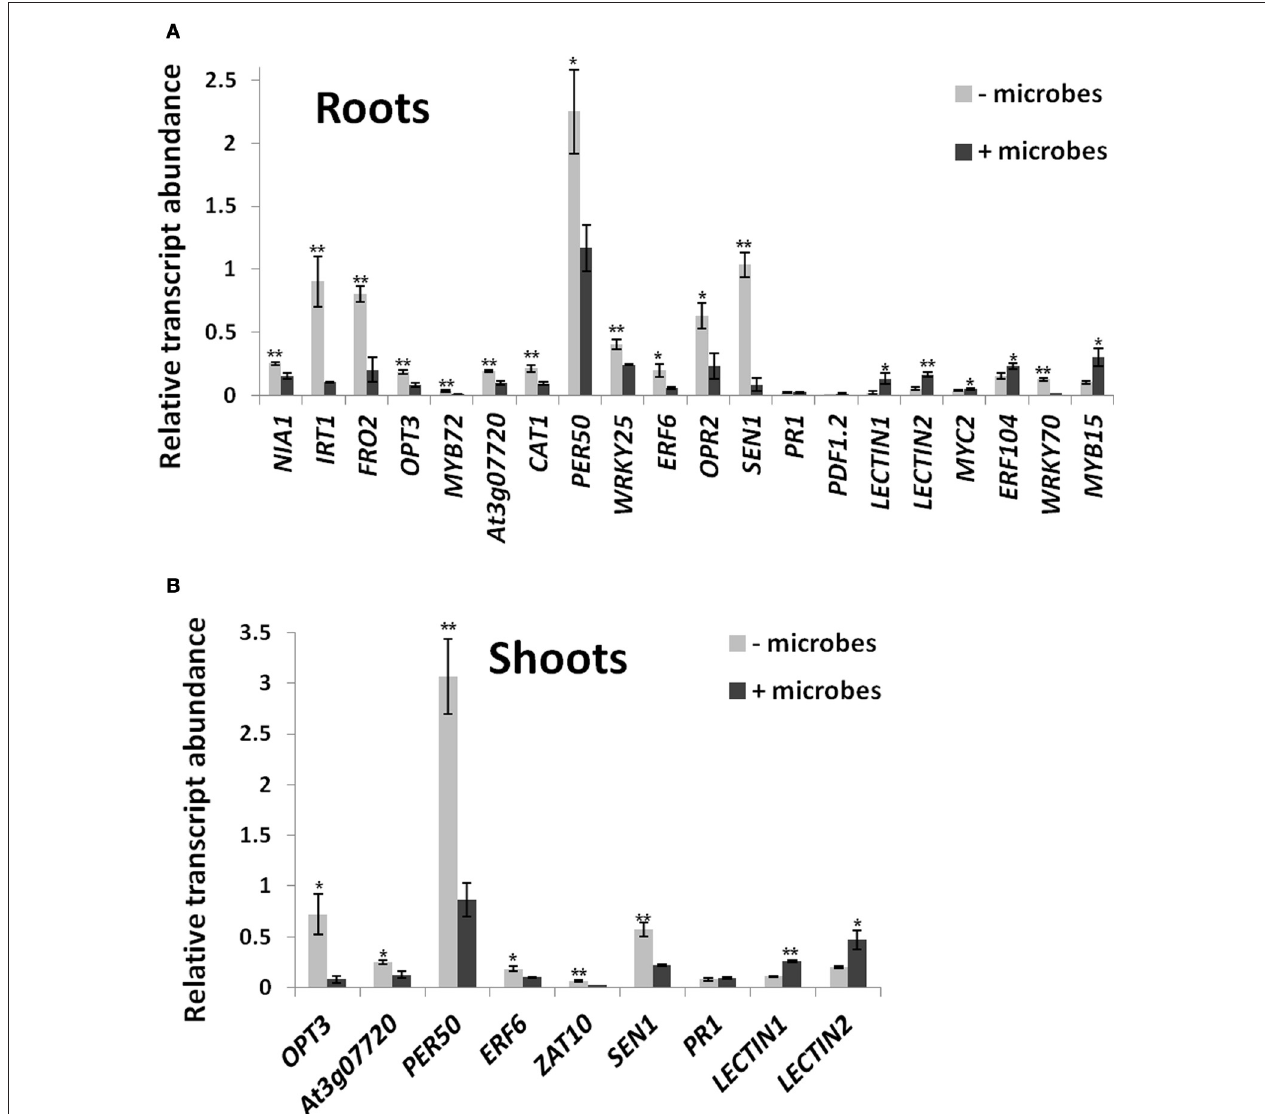
FIGURE 5 | Differential expression of marker genes in roots (A) and shoots (B) of Arabidopsis grown in soil in the presence or absence of whole microbial communities. Transcript abundances are shown relative to ACTIN genes measured by qRT-PCR from three independent